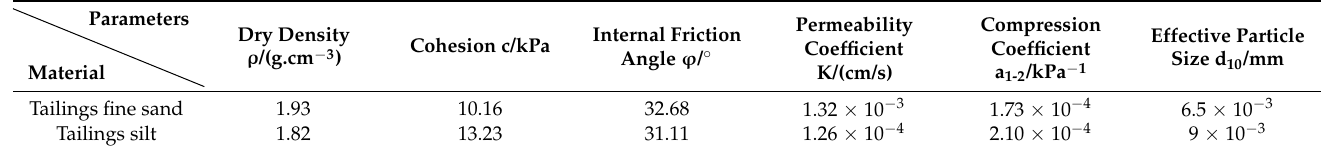
Table 1. Physical parameters of the experimental materials.